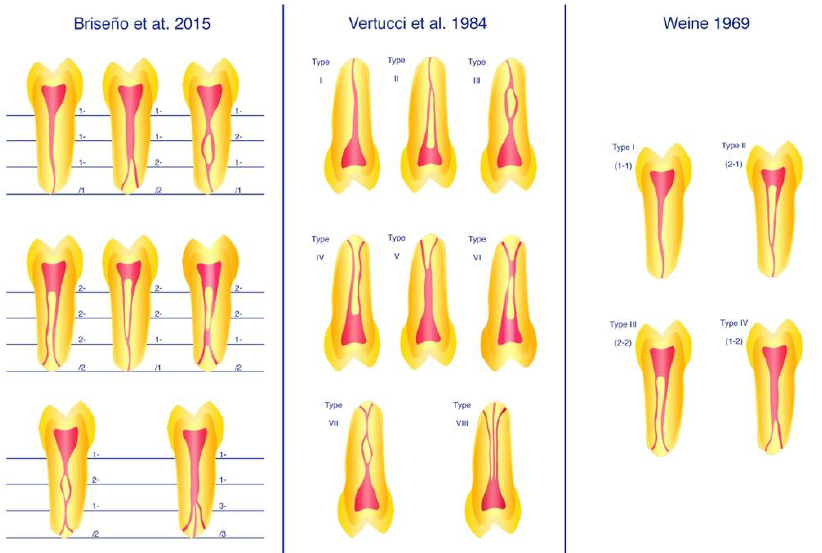
Figure 2. Classification systems proposed by Briseño-Marroquín et al. (2015) [3], Vertucci (1984) [1] and Weine et al. (1969) [2].